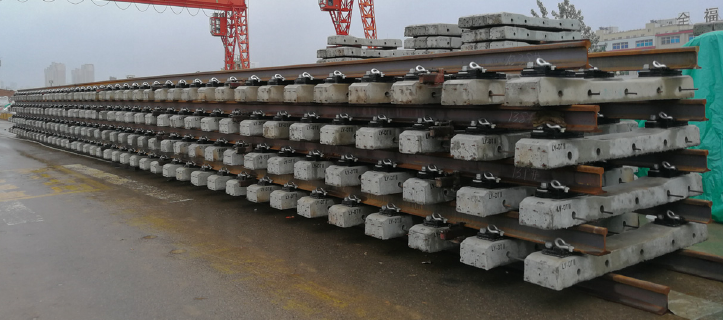
Figure 1. Picture of track panel.